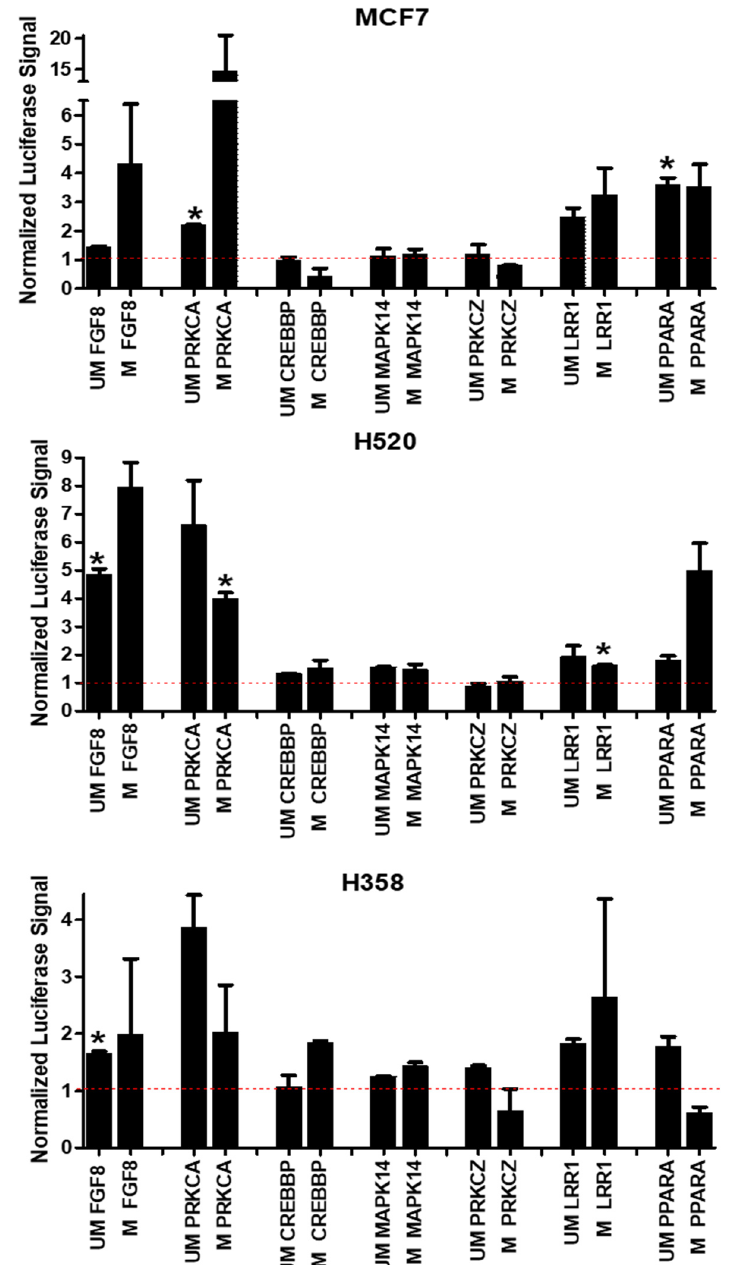
Figure 5. Isolated CpG islands from target genes are differentially responsive to Rlip knockdown. Promoter CpG islands upstream of the translation start site were cloned into a CpG-free firefly lu- ciferase reporter plasmid. Methylated and unmethylated versions of the constructs were transfected into cancer cell lines using Lipofectamine 3000 with P3000. The responsiveness of promoter constructs to Rlip knockdown by an Rlip-targeted locked nucleic acid (Rlip-LNA) was evaluated relative to the scrambled controls. The bars indicate the fold-change in signal produced by a given methylated or unmethylated reporter under conditions of Rlip depletion, relative to the signal produced by the construct under the corresponding scrambled control condition, which was defined as equal to 1. To avoid overcrowded graphs, the signals produced under the scrambled condition are not shown using bars, but are instead indicated by the horizontal red dotted line at y = 1. Asterisks (*) indicate p < 0.05 by Student’s t- test when comparing luciferase signal from each Rlip-LNA treatment to its corresponding scrambled control treatment. Error bars represent SEM. UM: unmethylated. M: methylated. Error bars indicate SEM ( n = 2).